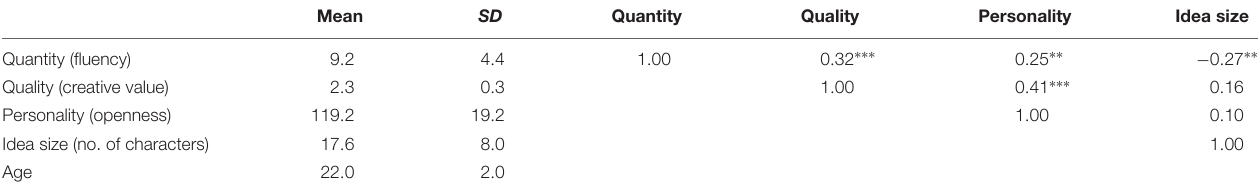
TABLE 1 | Descriptive statistics and correlation matrix.